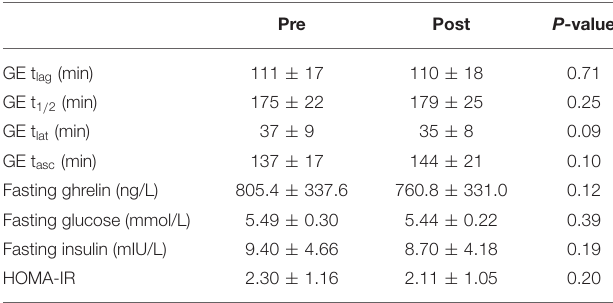
TABLE 2 | Gastric emptying time based parameters, fasting ghrelin, glucose, insulin, and HOMA-IR Pre and Post 4 week exercise intervention ( n =